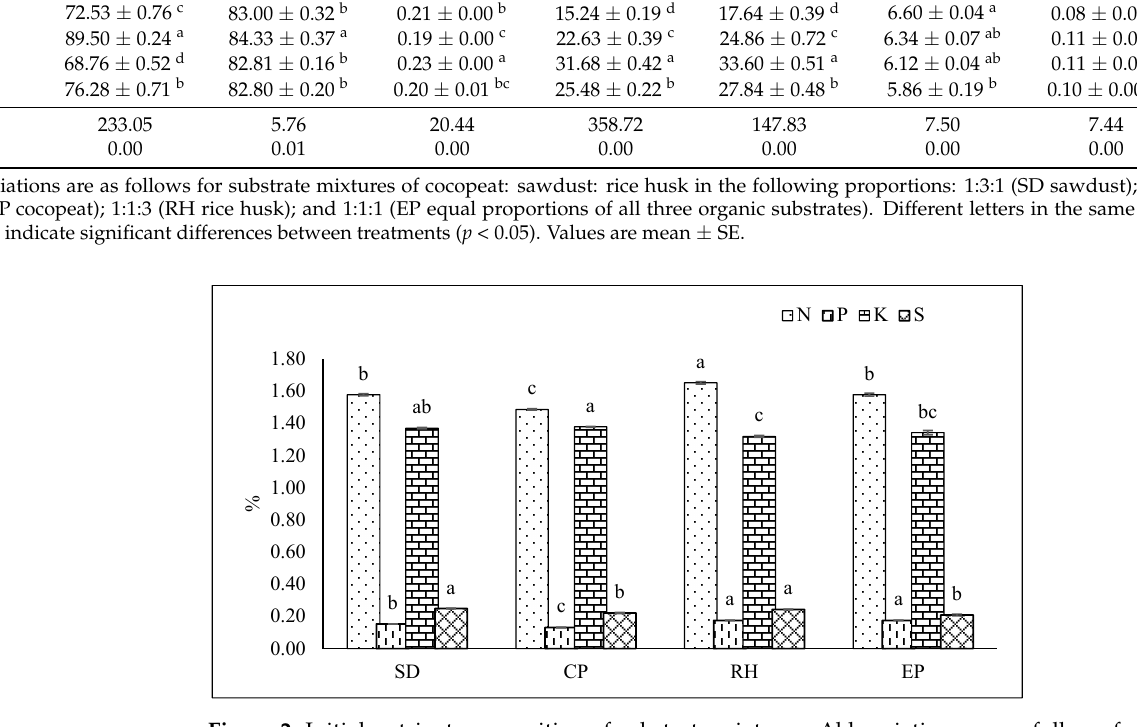
Figure 2. Initial nutrient composition of substrate mixtures. Abbreviations are as follows for sub- strate mixtures of cocopeat: sawdust: rice husk in the following proportions: 1:3:1 (SD sawdust); 3:1:1 (CP cocopeat); 1:1:3 (RH rice husk); and 1:1:1 (EP equal proportions of all three organic sub- strates). Different letters in the same column indicate significant differences between treatments ( p < 0.05). Vertical bars indicate standard errors of means.